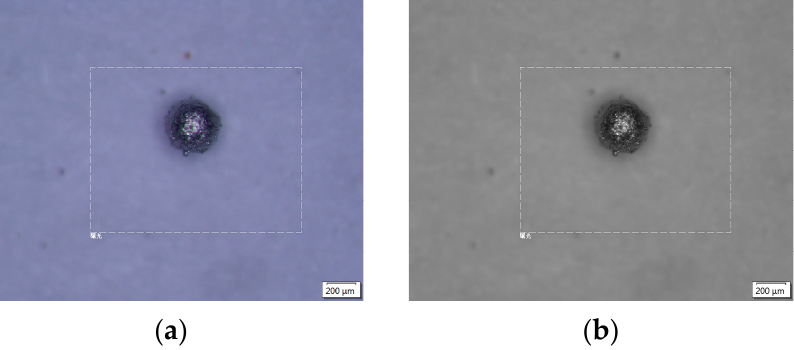
Figure 3. Grayscale processing of oil particle image: ( a ) Original picture of oil particles; ( b ) Grayscaled image.